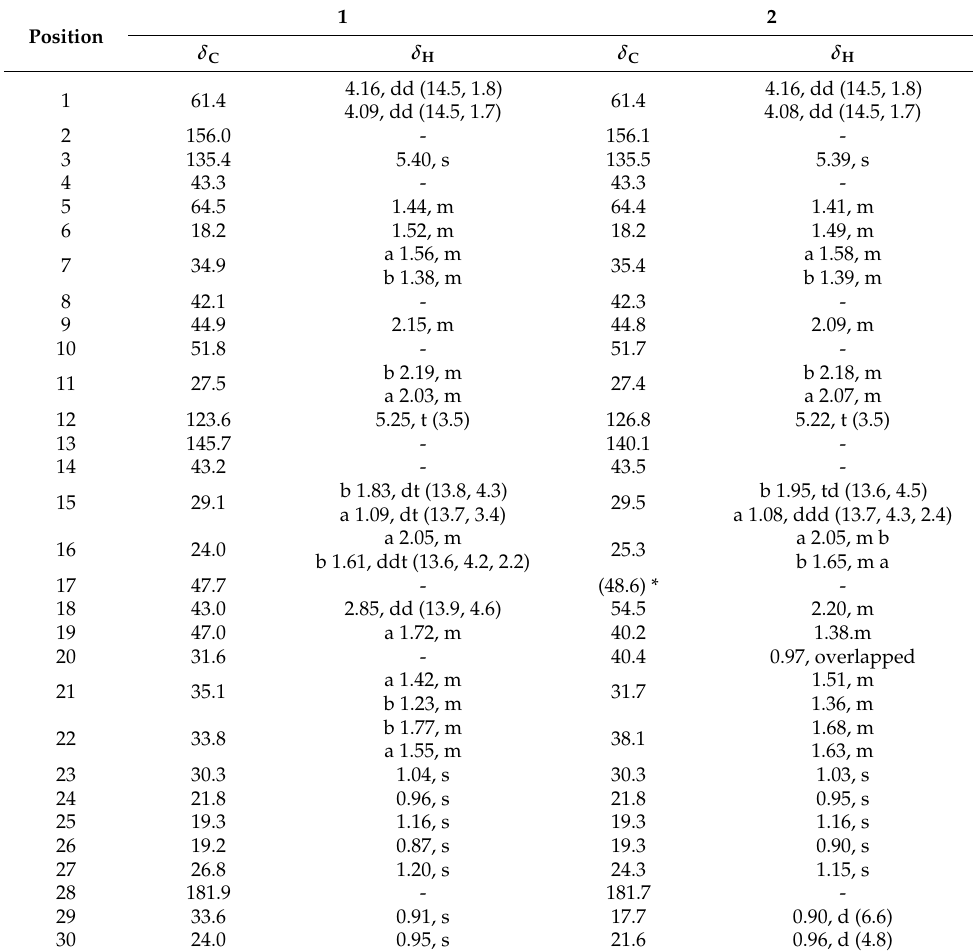
Table 1. The 1 H and 13 C-NMR data of 1 and 2 (600/150 MHz, CD 3 OD, δ in ppm, J in Hz). 1 2 Position δ